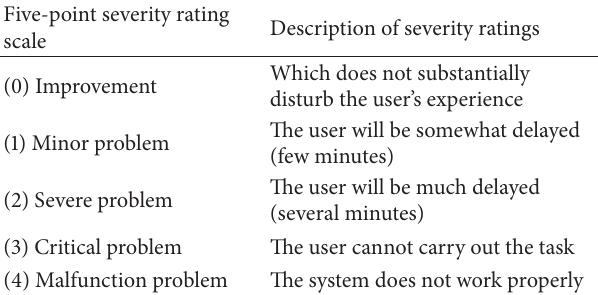
Table 2: Rolf Molich’s severity rating